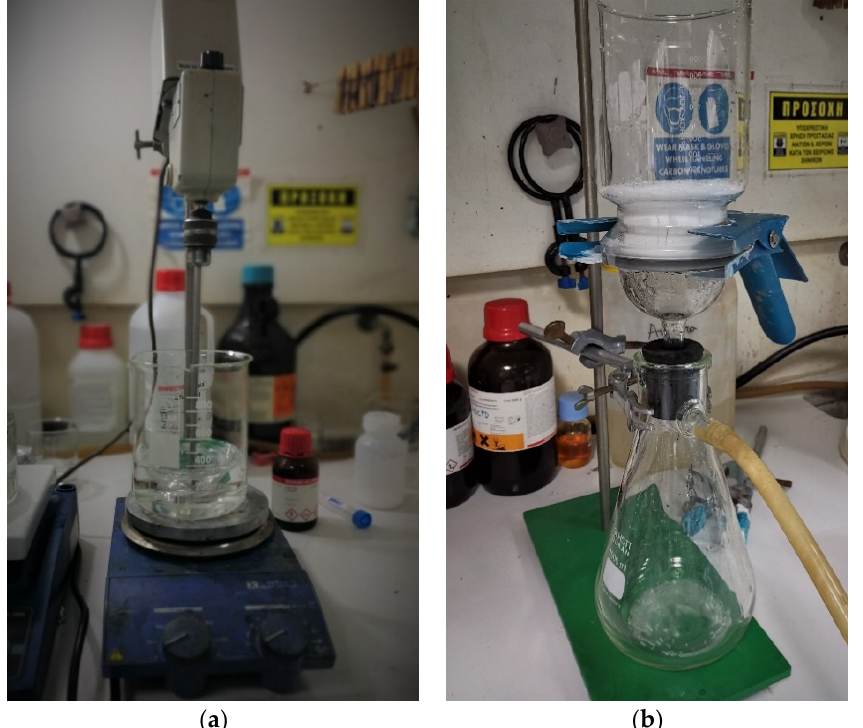
Figure 1. Snapshots from the SH capsules fabrication process: ( a ) sonicator use; ( b ) vacuum filtering and drying.